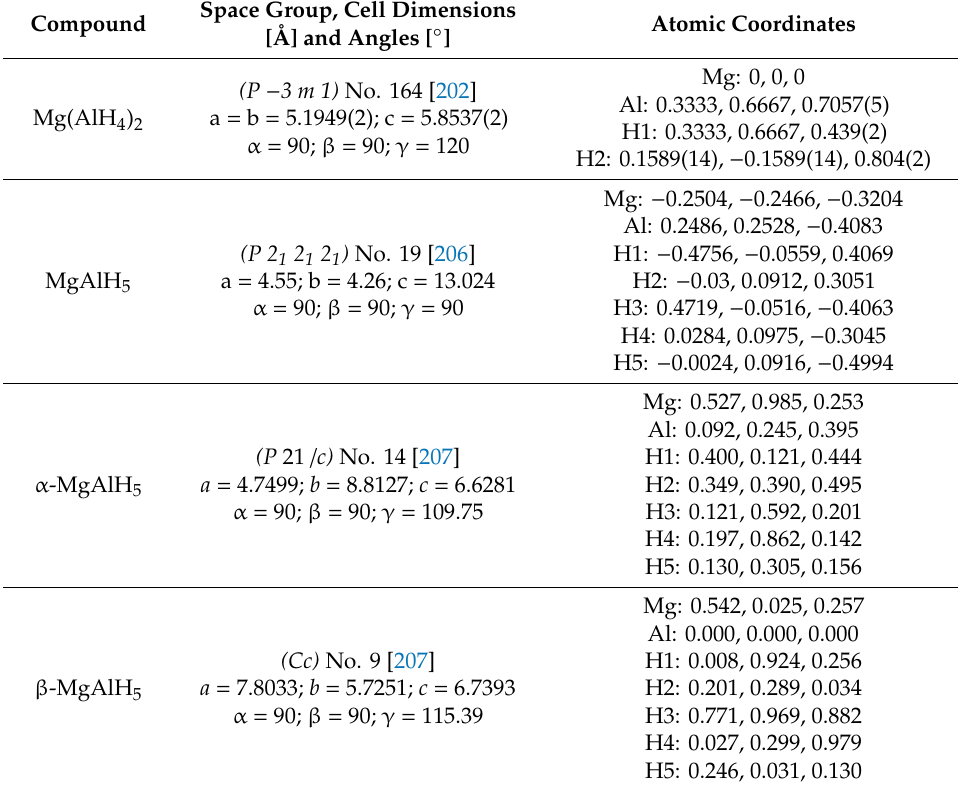
Table 8. Crystallographic data of magnesium